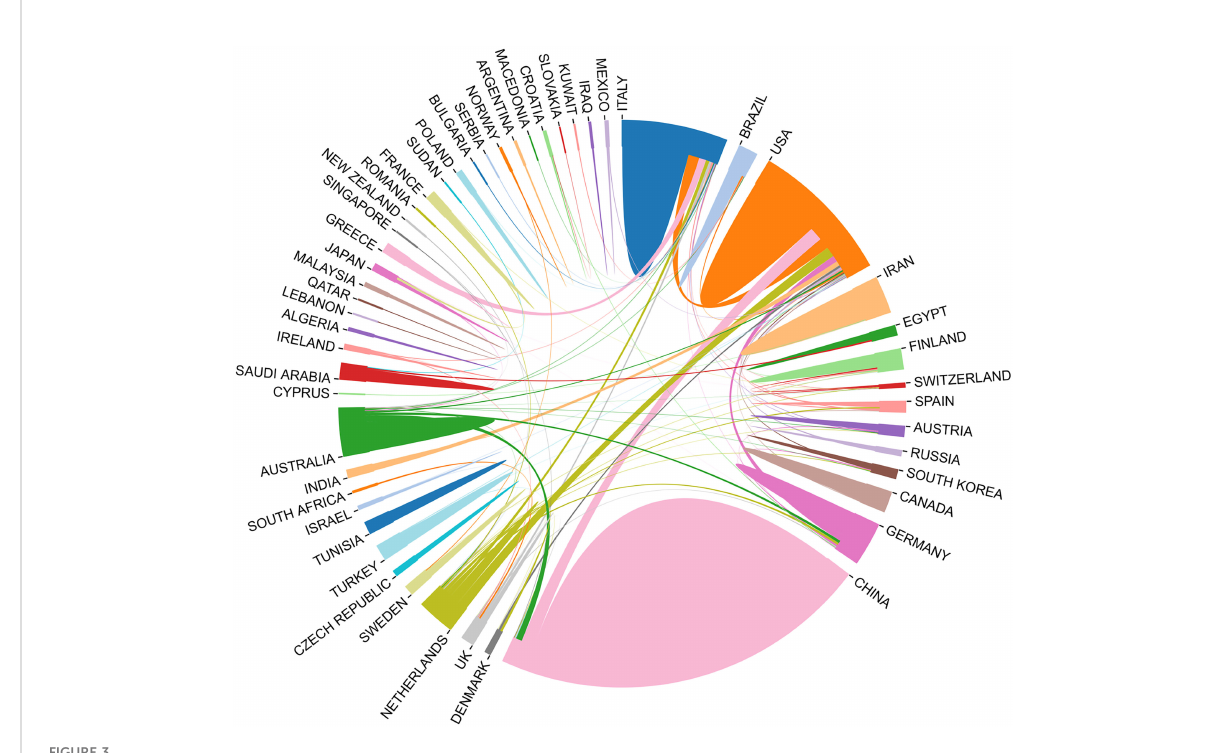
FIGURE 3 The network map of collaboration between